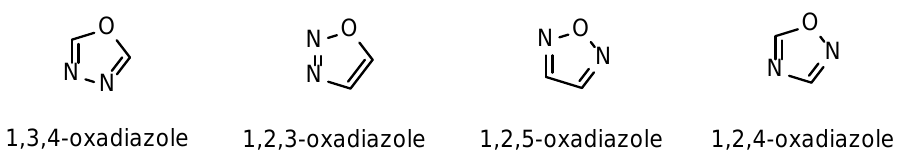
Figure 2. Isomeric structures of oxadiazoles [20].